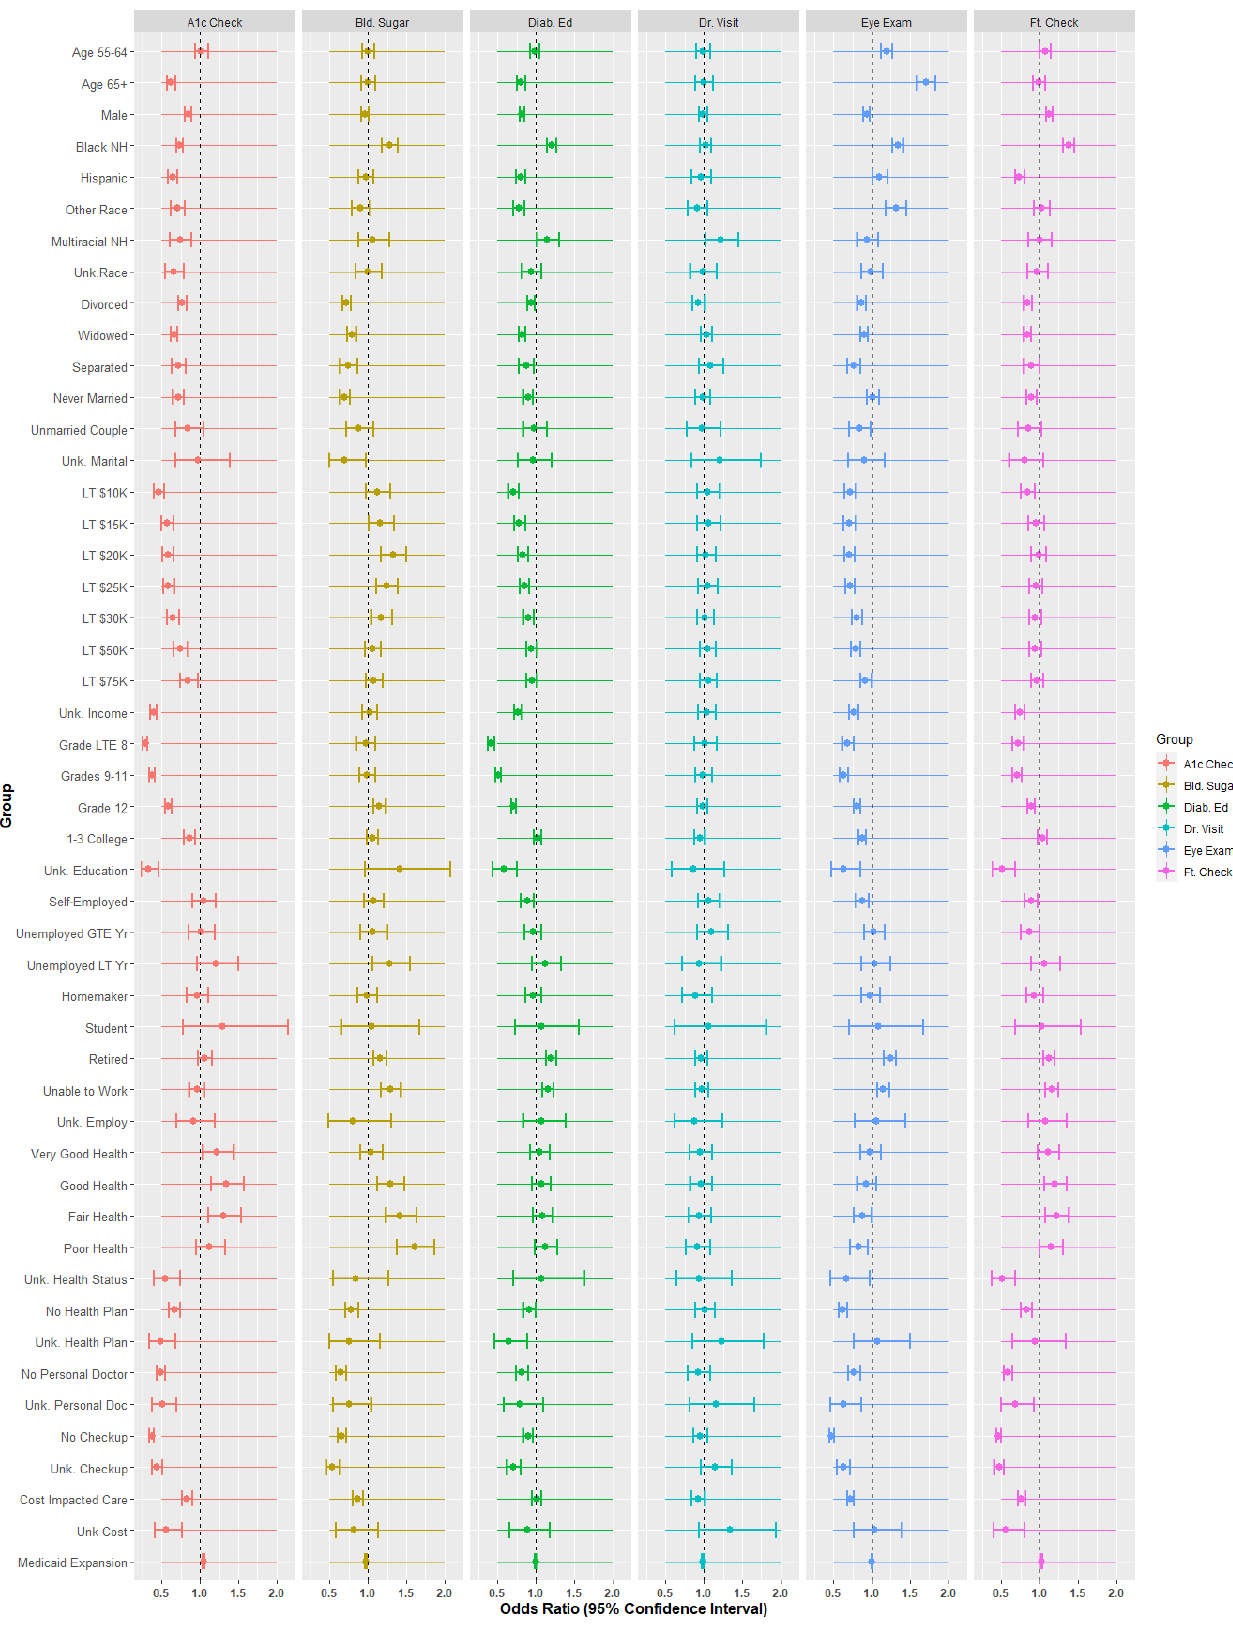
Figure 6. Side-by-side forest plots with vertical lines showing the 95% confidence intervals.